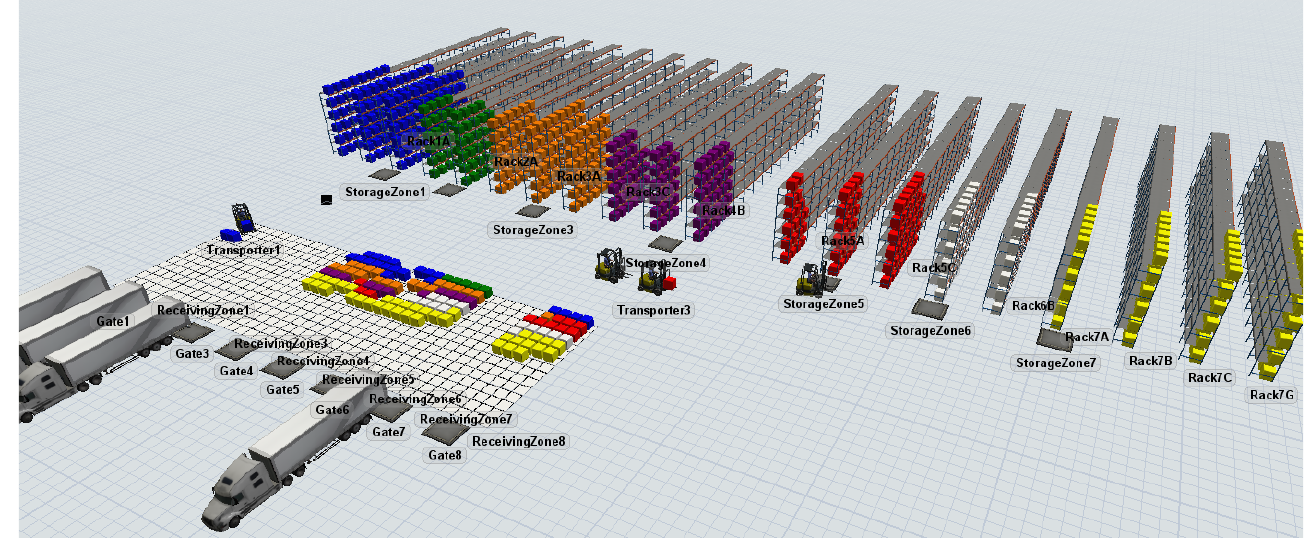
Figure 1. Layout of the distribution warehouse ’s inbound side.